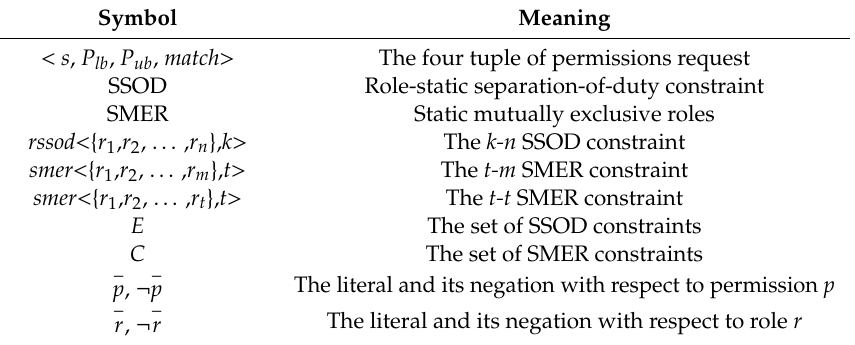
Table 1. Main symbols and their